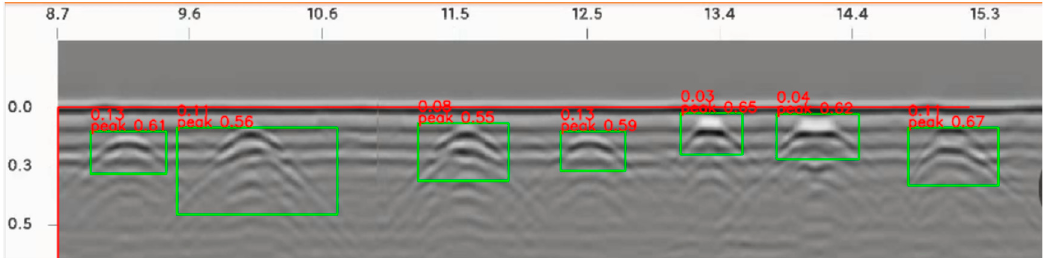
Figure 22. Target location results of ground penetrating radar image 2.